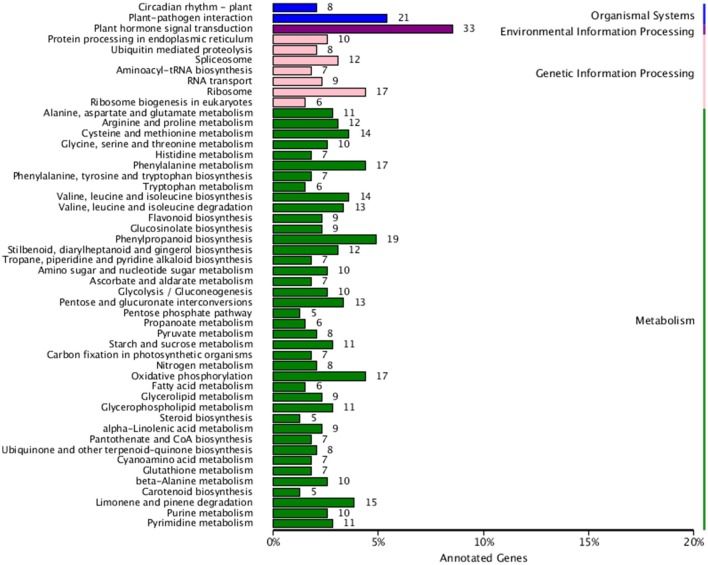
Kyoto Encyclopedia of Genes and Genomes (KEGG) functional classification of differentially genes expressed in JL-08 and JL-09 sprouts. The X axis is the rate of annotated genes to different categories of KEGG. The Y axis represented different categories of KEGG in JL-08 and JL-09 sprouts. Blue column, organismal systems; Purple column, Environmental information processing; Pink column, Genetic information processing; Green column, Metabolism.